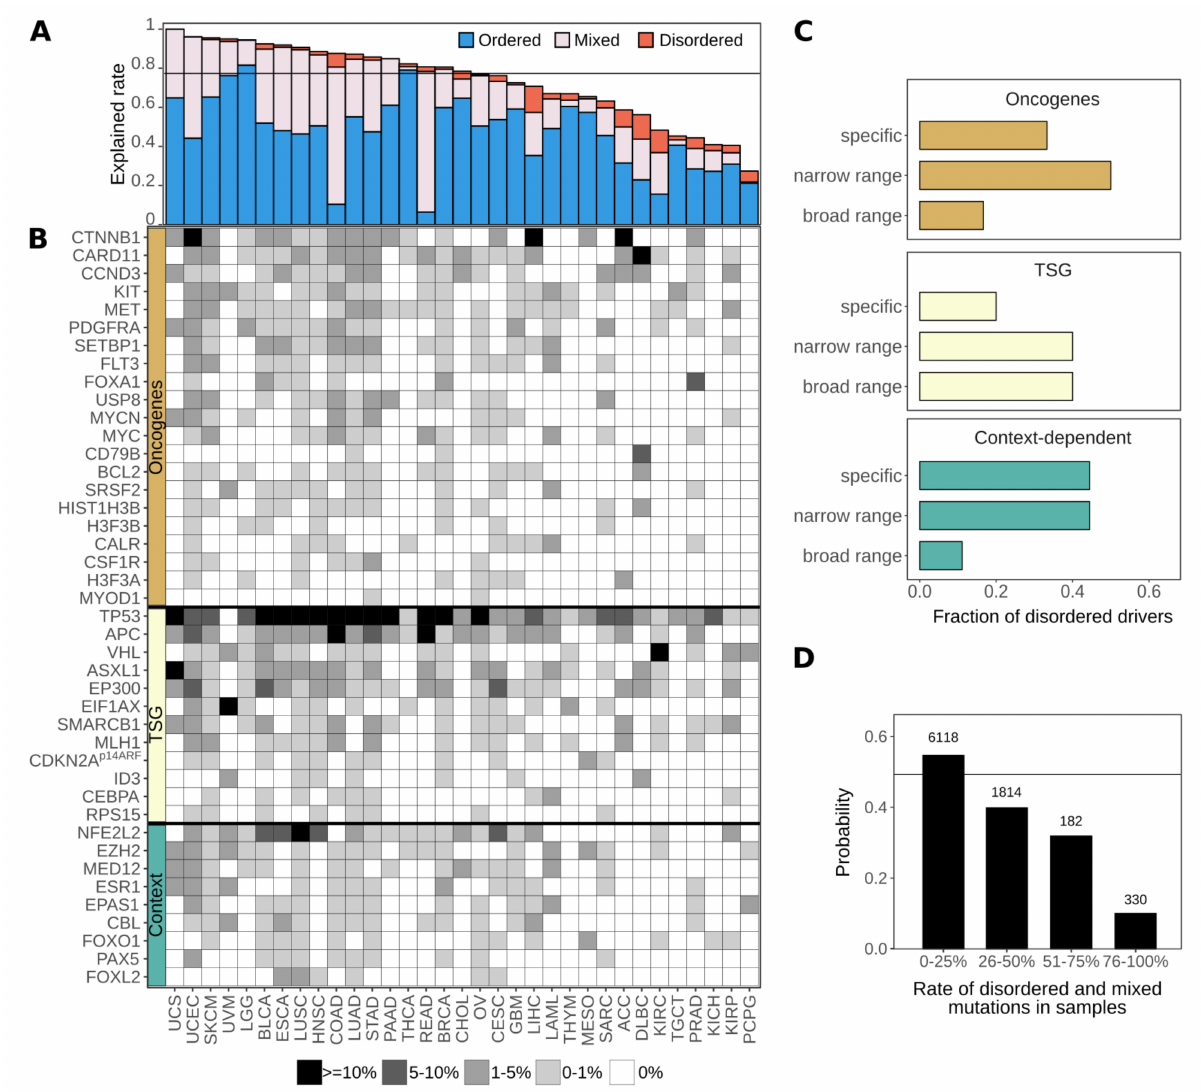
Figure 5. Therapeutic options for targeting disordered drivers. ( A ) Fraction of samples that contain altered driver genes per cancer type. Samples can contain mutations affecting only ordered drivers (blue), only disordered drivers (red) or both (mixed, gray). ( B ) Percentage of cancer samples, grouped by cancer types, containing genetic alterations that target the identified disordered driver regions. ( C ) The distribution of disordered drivers from the three classes of cancer genes (oncogenes, tumor suppressor genes (TSG) and context dependent genes) categorized into specific, narrow and broad range based on the frequency of samples they are mutated in (see Data and Methods). ( D ) The probability of having an available FDA-approved drug for at least one mutation-affected gene for patients, as a function of the ratio of affected disordered genes compared to all mutated genes in the sample. The horizontal black line represents the total fraction of targetable samples (0.49) from 8444